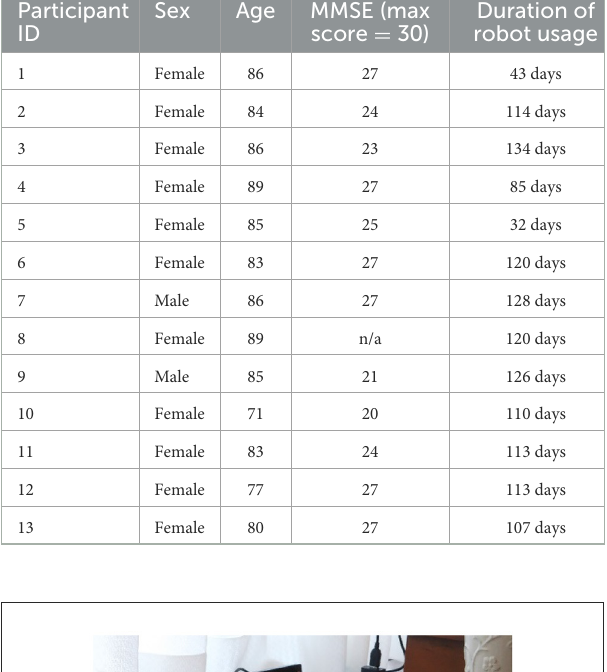
TABLE 2 Profiles of interviewees other than older adult participants, i.e., their relatives and supportive staff